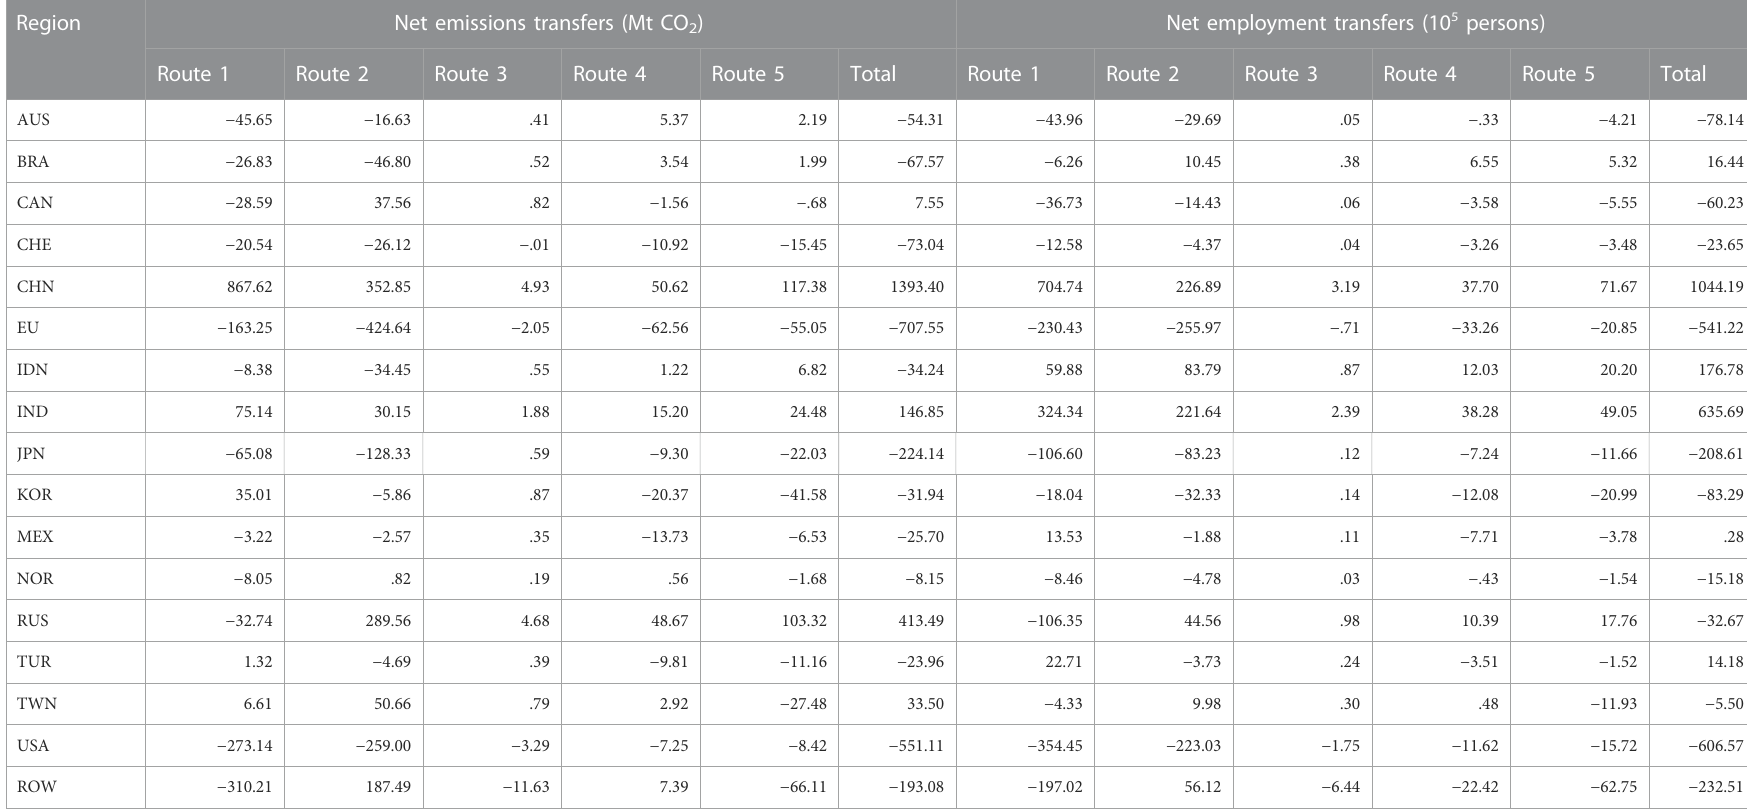
TABLE 3 Net transfer of embodied carbon emissions and embodied employment for each economy in 2014.